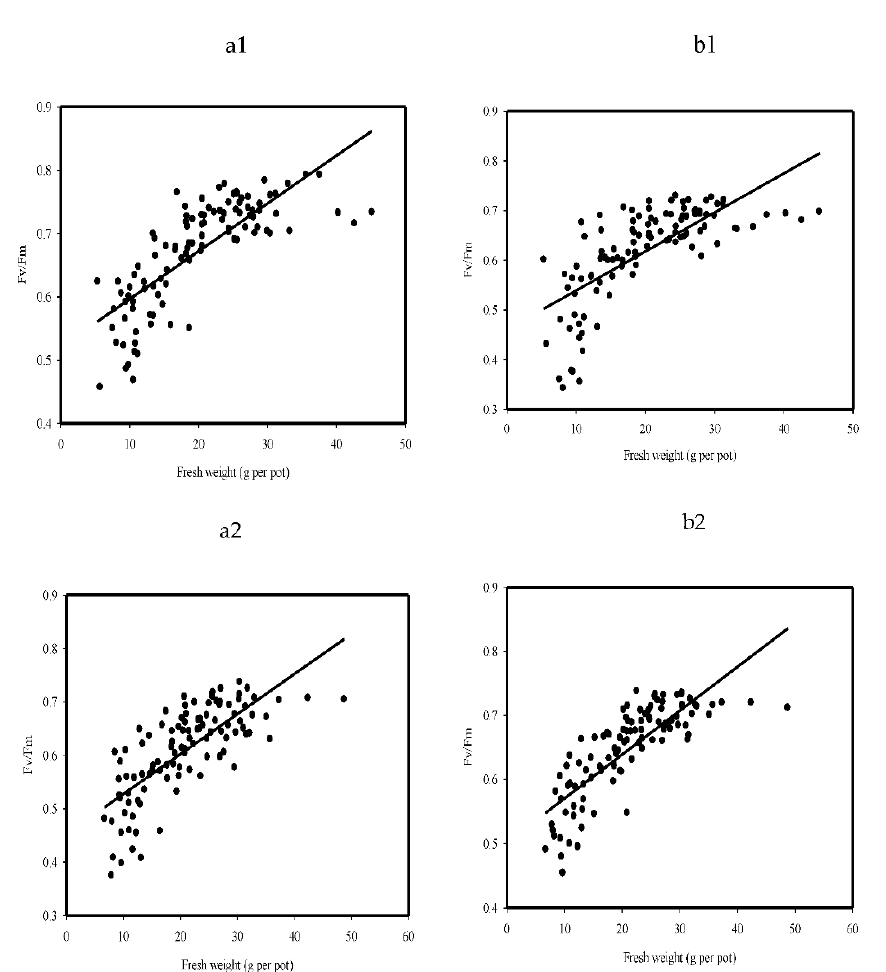
Figure 6. Linear regression of the maximum quantum photosystem II (F v /F m ) on Fresh weight, 4 days ( a1 , a2 ) and 8 ( b1 , b2 ) days after treatment in potato and fresh weight 3 weeks after treatment for metribuzin:halosulfuron in first ( a ) and second experiment ( b ). Each data point on the graph represents one replication of potato with indifferent mixture herbicide.